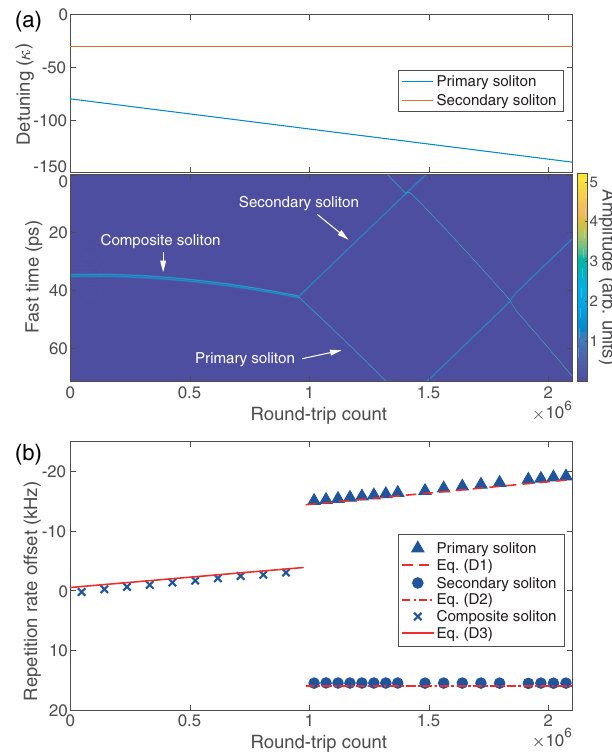
FIG. 10. Simulation of switching. (a) Evolution of the intra- cavity field when a composite soliton decomposes into two unbound distinct solitons. The effective detunings of the primary pump and the secondary pump are shown in the upper panel. (b) The numerically computed instantaneous soliton repetition rates relative to ð D 1 = 2 π Þ . The theoretically calculated repetition rates are plotted in red